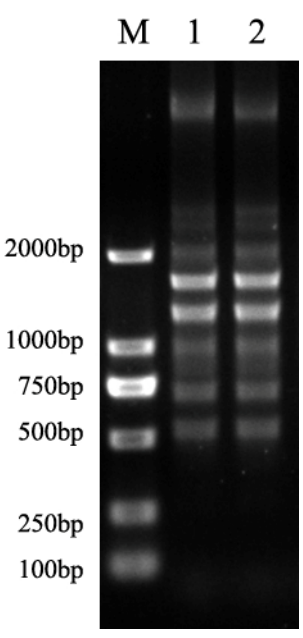
Figure 1. Fingerprinting patterns of two representative strains.